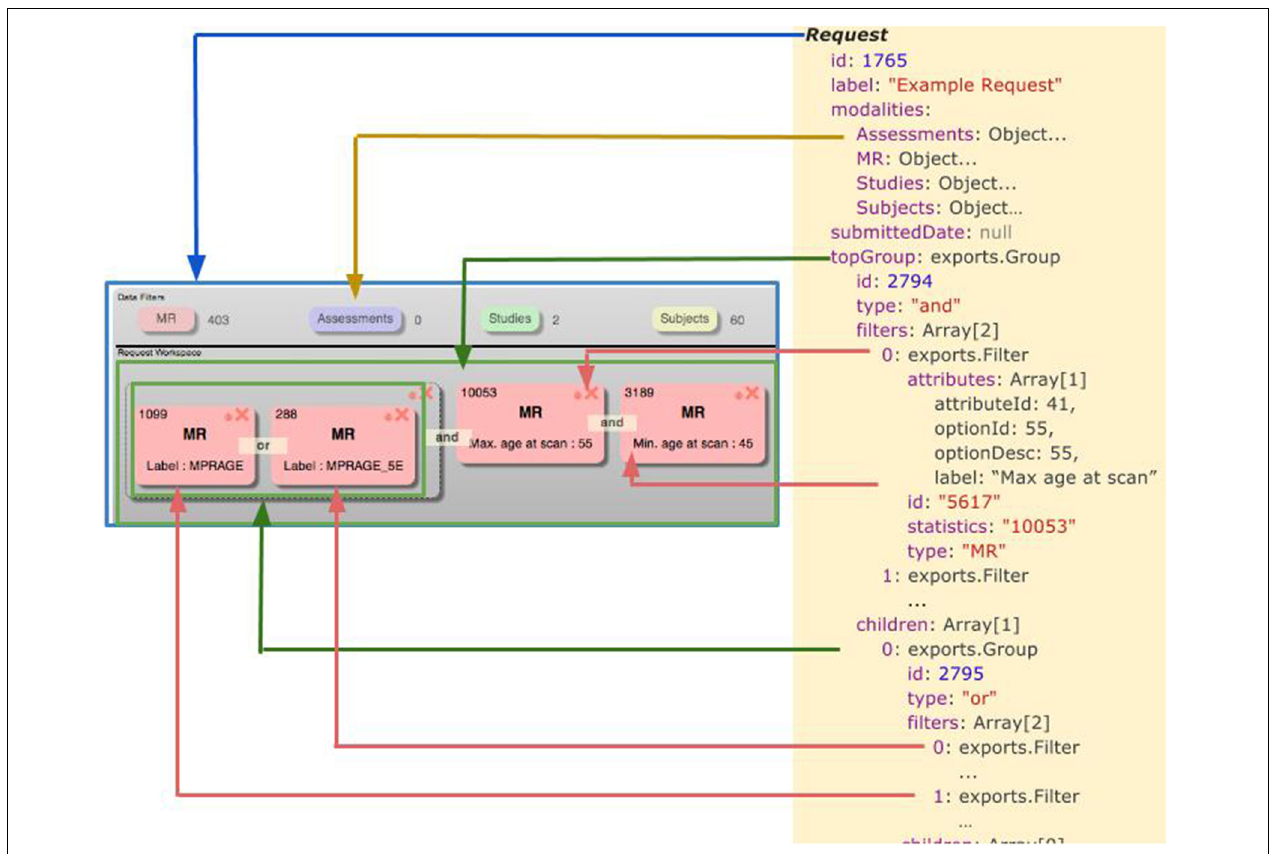
FIGURE 3 | Simplified model of a data catalog